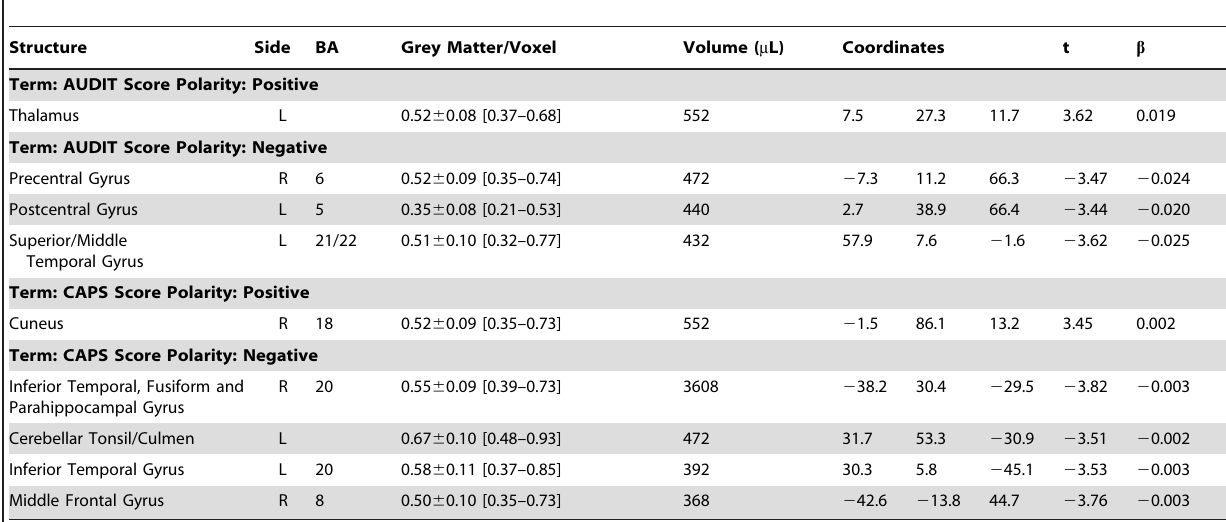
Table 3. Results from regression analyses investigating relationship between post-deployment symptoms and gray matter